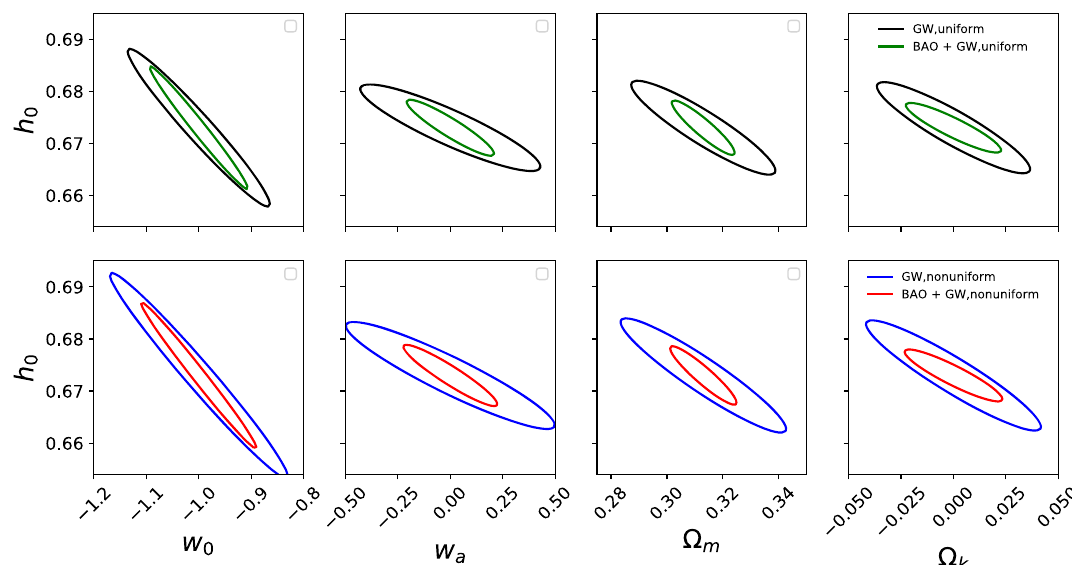
Fig. 6 The 2D contours between h 0 and w 0 , w a , Ω m , Ω k at 68% CL. The upper/lower panels denote the uniform/nonuniform distribution of GW sources. The black and blue curves refer to the ET, while the green and red ones refer to the combinations of ET and DESI Table 9 The DESI BAO Fisher matrix